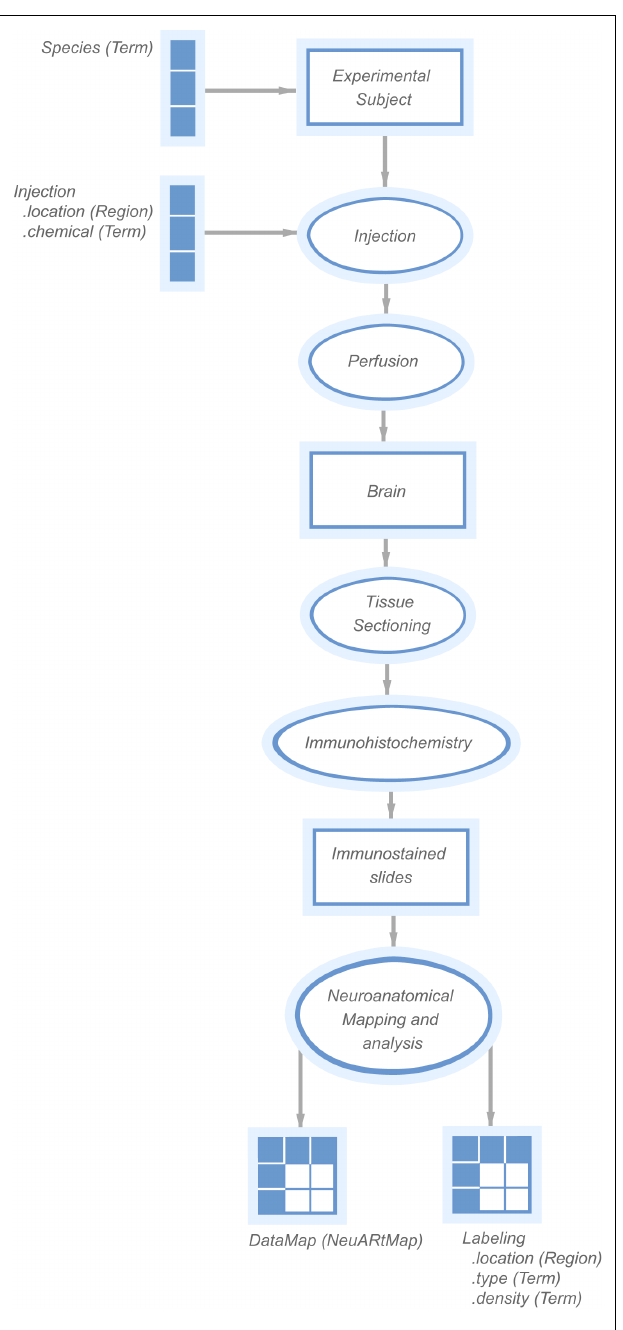
FIGURE 2 |A “KEfED” model for tract-tracing studies as it appears within the KEfED editor system. This forms the basis of the interaction between the spatial and semantic representations of these experiments.